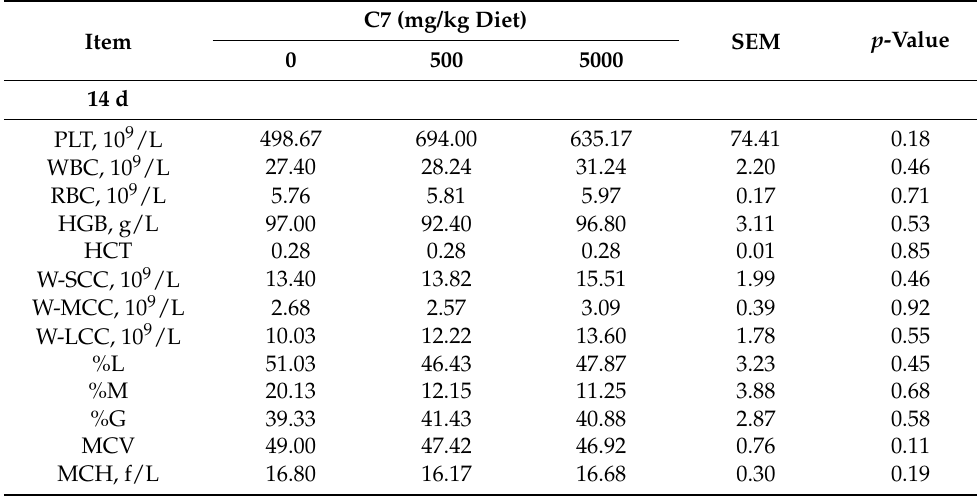
Table 9. Effects of high-dose C7 supplementation on blood routine